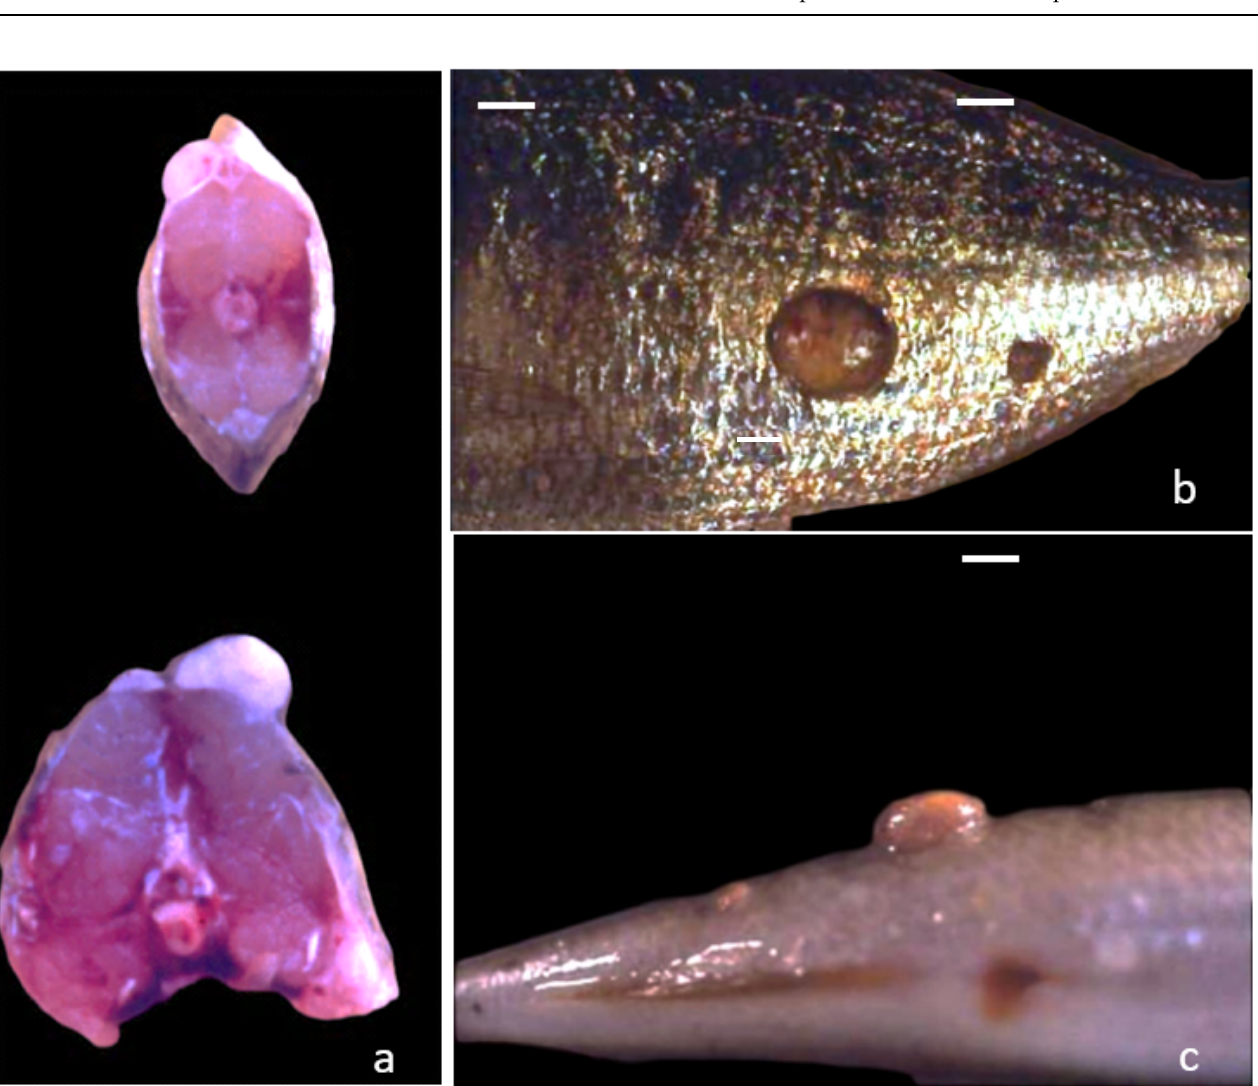
Figure 1. Cut section ( a ) and lateral ( b ) and dorsal ( c ) view of the masses on striped sea bream showing the exophytic growth and a well-circumscribed appearance, mainly present on fish flank. Multiple masses are present on the same fish (bar = 1 cm).